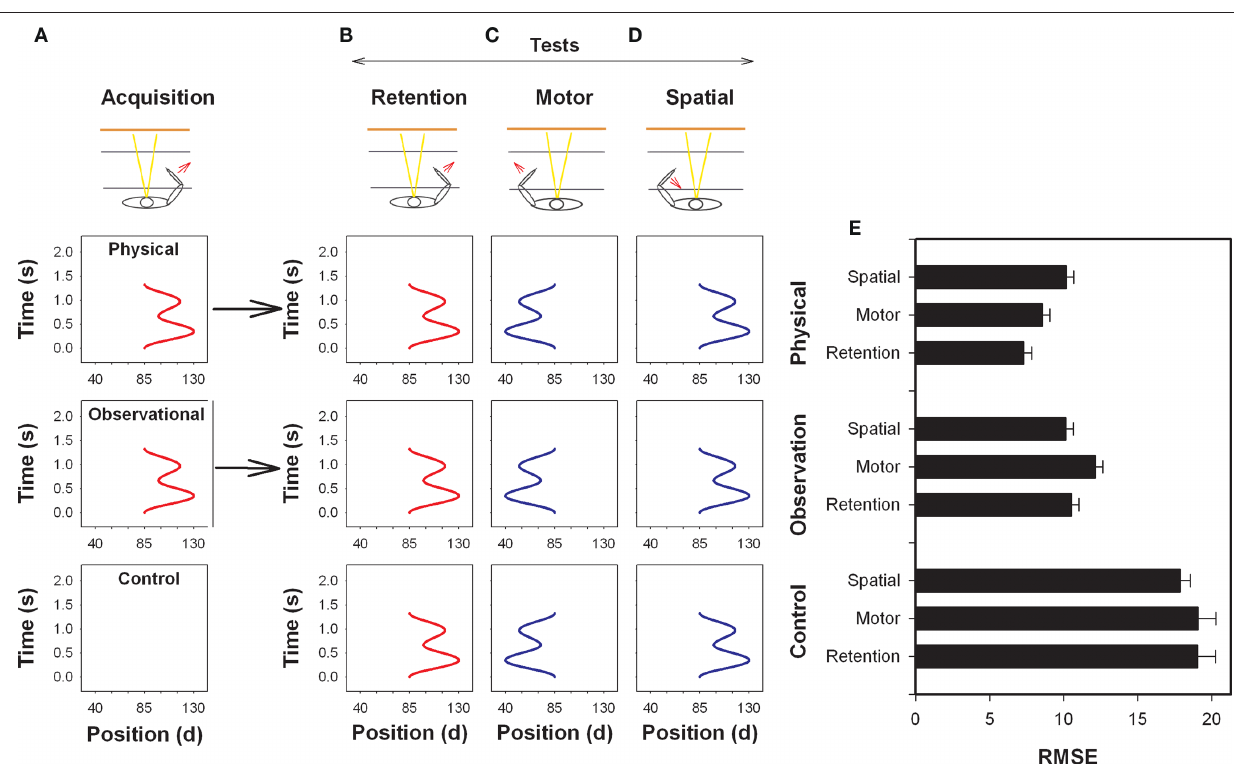
displayed for the physical and observational practice groups. Note that the start position between the upper and lower arm in this task was 85 ° . RMSE means and SEs by test is provided in (e) . (Redrawn from Gruetzmacher et al., 2011).